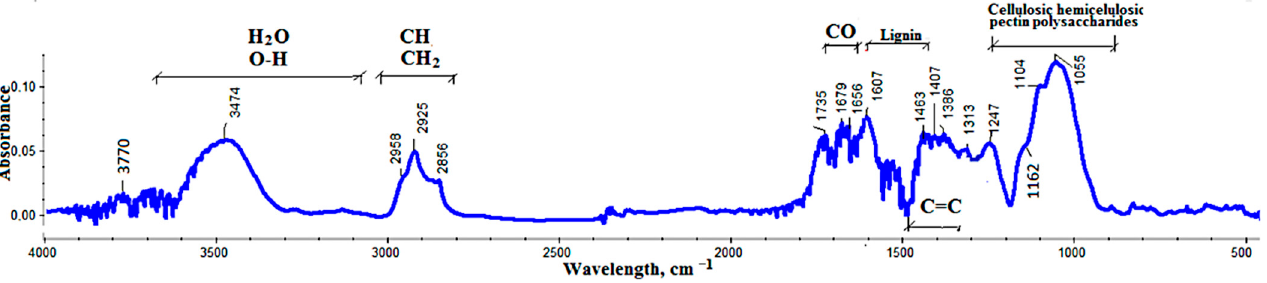
Figure 1. FTIR spectrum of hop residue. Table 1. FTIR analysis results of hop residue.